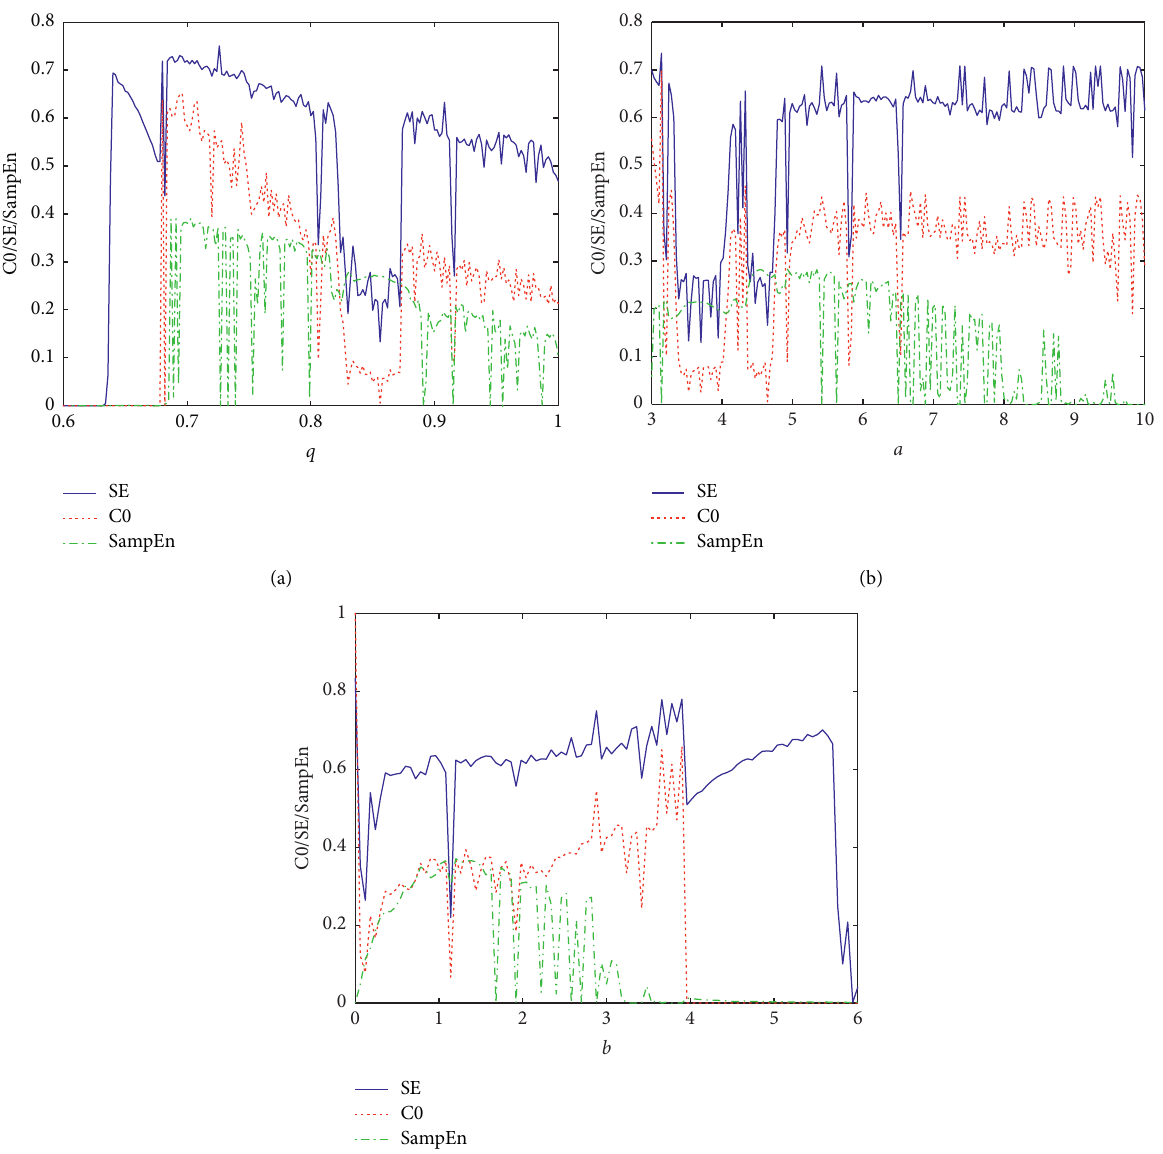
Figure 11: Complexity of the system with parameter varying. (a) q varying. (b) a varying. (c) b Figure 11(c). The change of complexity is consistent with the change of Lyapunov exponent in Figure 10(b).